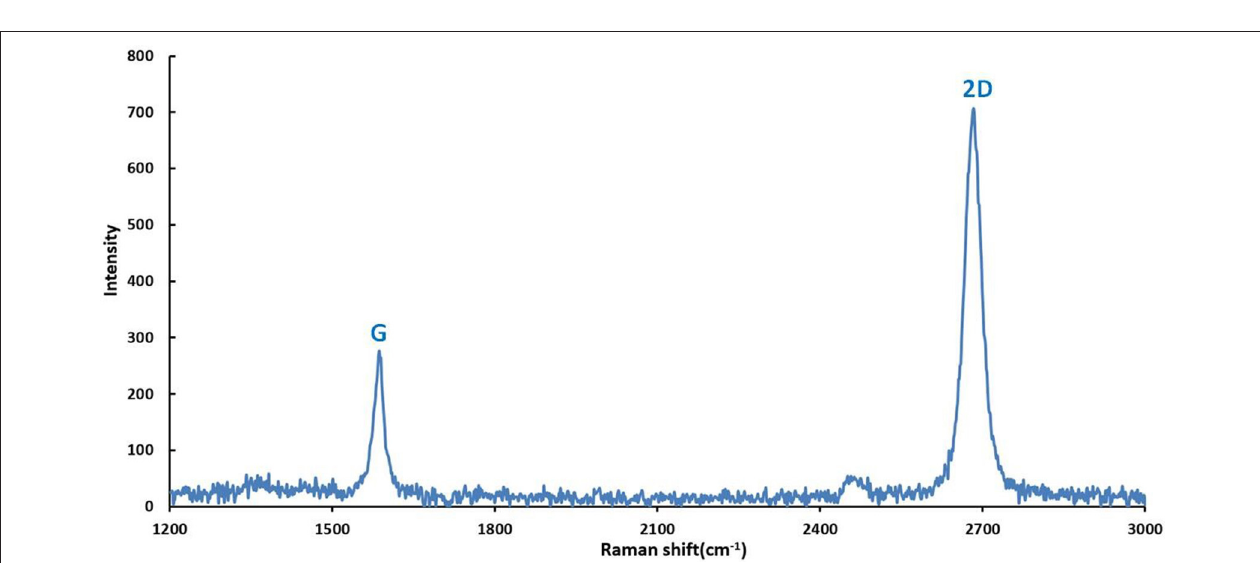
Frontiers in Chemistry |